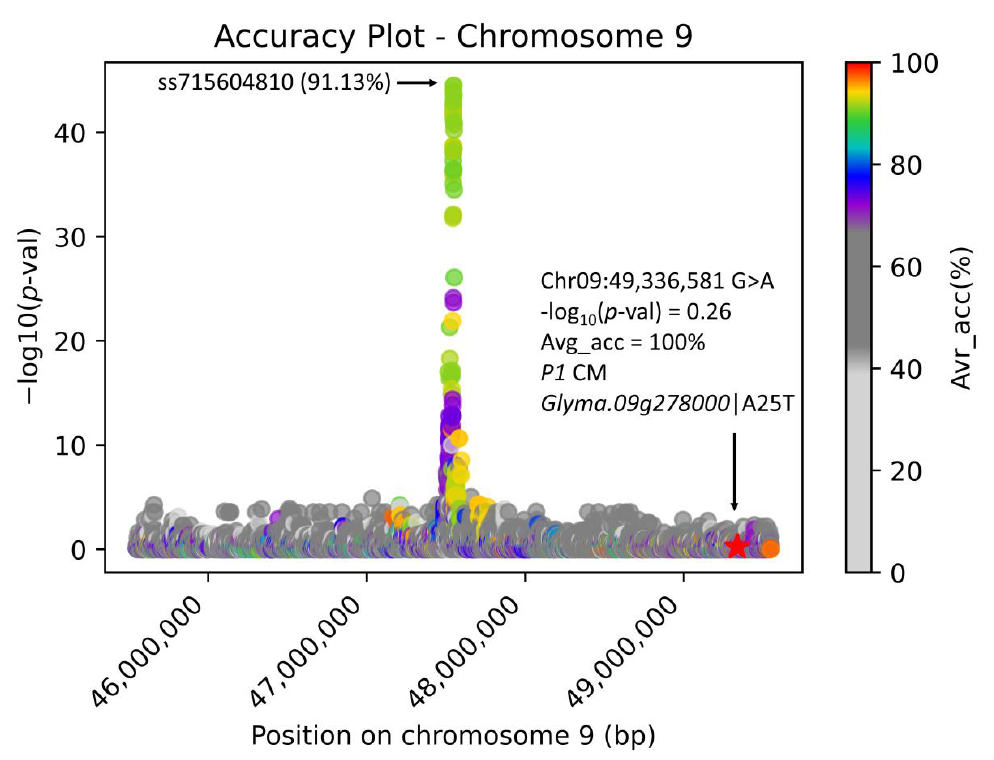
Figure 6. The AccuCalc chromosome-wise view of the 4 M bp region on chromosome 09 with the asso- ciated region to ss715604810, P1 tagging marker [16]. The Manhattan plot for the soybean USB15x(302) resequenced data and ss715604810 synthetic phenotype with Avr_accu of the glabrous/pubescent phenotype. The arrow points to the Glyma.09g278000 -A25T causative